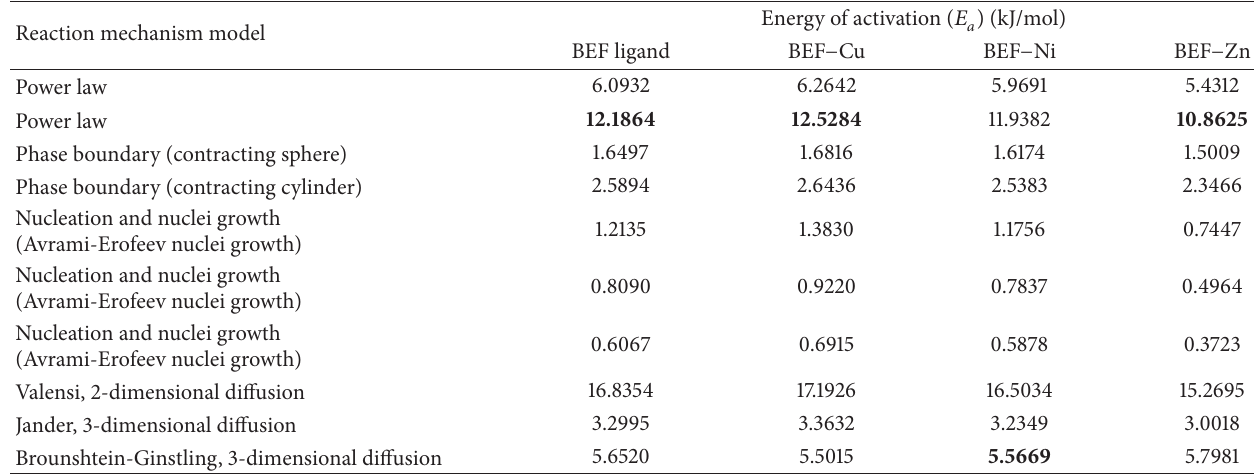
Table 6: Activation energies calculated by Phadnis-Deshpande